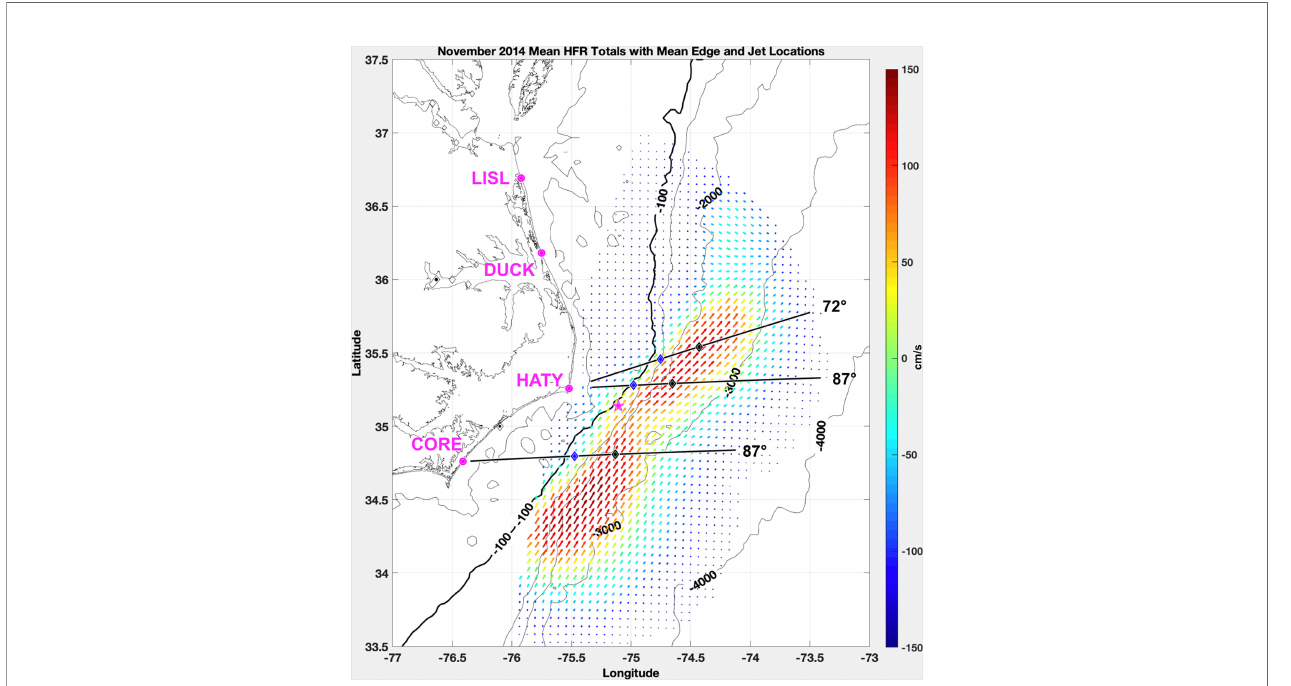
FIGURE 3 | A map of the study focus region. ADCP mooring is the pink star just offshore of the 100 m bold isobath. Land-based HF radars are located at the pink dots with their 4-letter identi fi ers. Mean GS edge and jet positions at blue diamonds and black diamonds respectively, along select HFR bearings from CORE and HATY for November 2014. The colored vector fi eld shows the mean total surface current speeds from the radar network for November